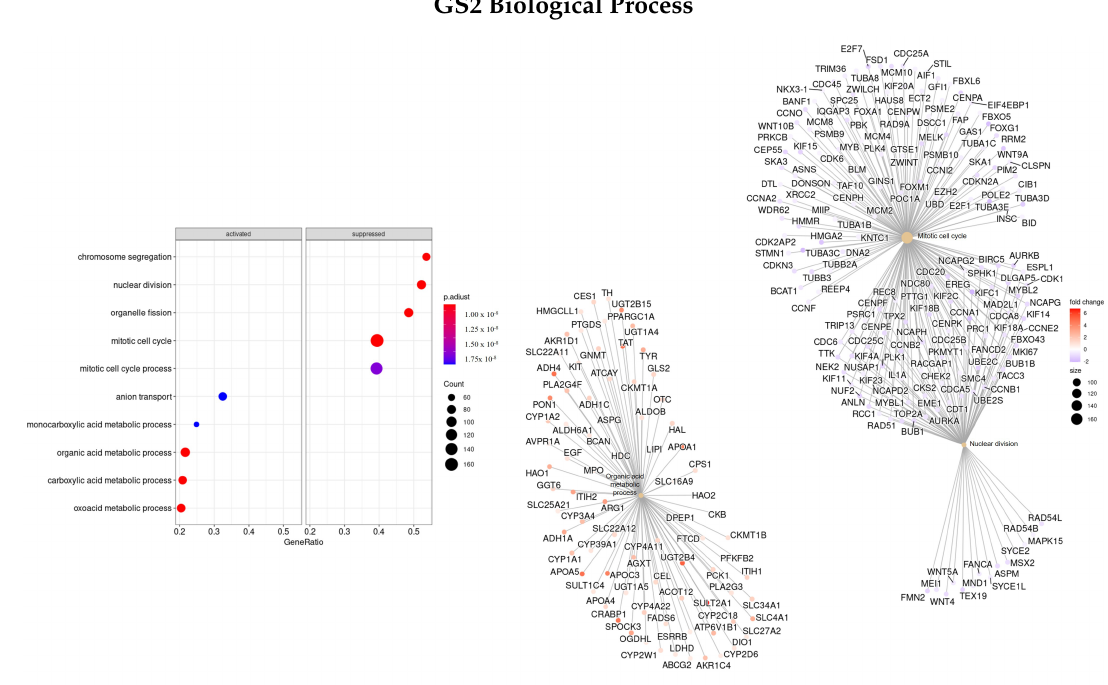
Figure 4. Gene ontology enrichment analysis regarding biological processes terms for a list of DEGs ranked by the log fold change between early and advanced stages of the disease. The left panel shows a dot chart with the most significant BP terms. The right panel shows a gene-concept network plot of the three most enriched terms that depicts the linkages of genes and biological concepts as a network.